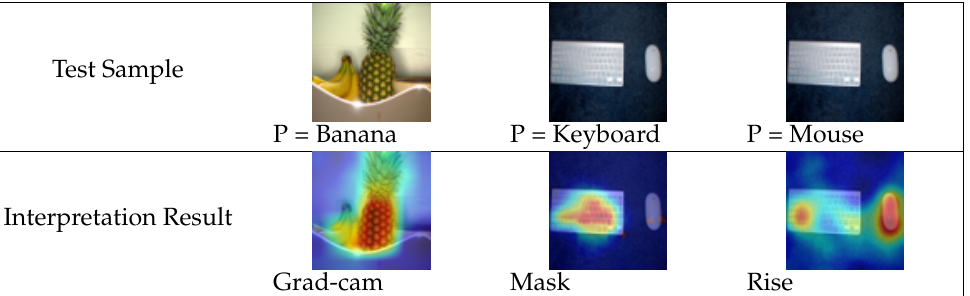
Table 5. Cases in class-discriminativeness of different interpretation algorithms (P means the model prediction result).